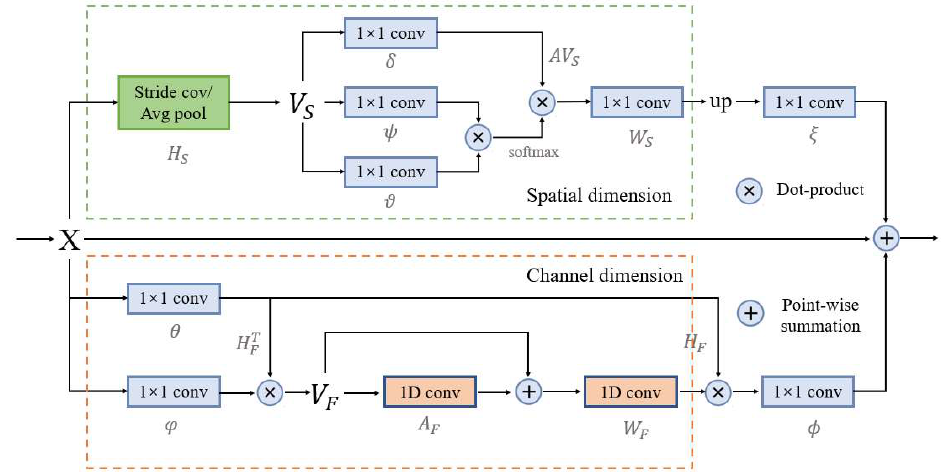
Figure 5. Structure of the dual graph convolutional module in the BGC-Net. This module consists of two branches, which each consist of a graph convolutional network (GCN) to model contextual information in the spatial- and channel-dimensions in a convolutional feature map, X.